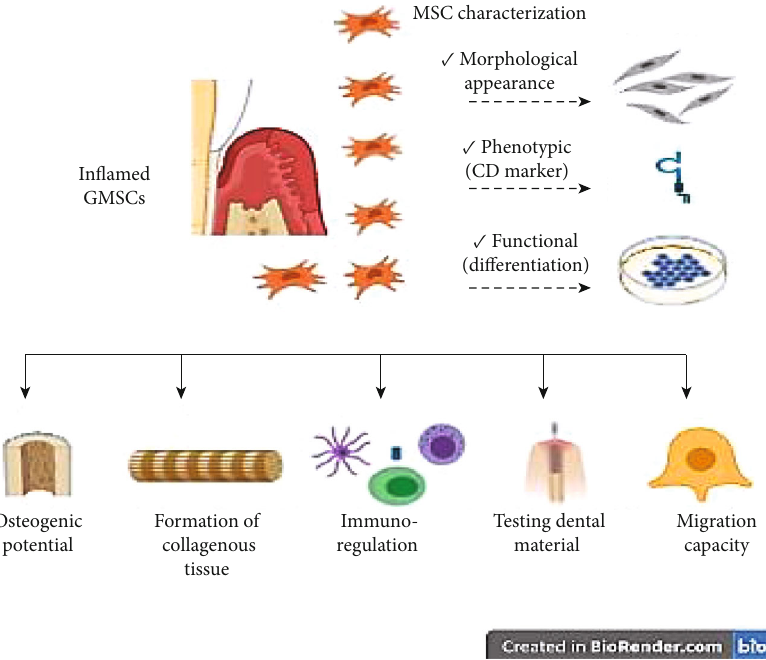
Figure 2: Possible applications and therapeutic roles of in fl amed gingiva-derived mesenchymal stem